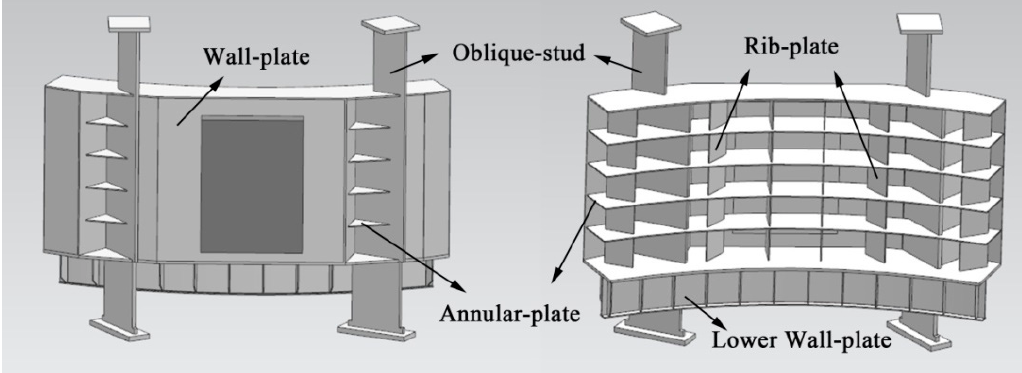
Figure 1. Structure diagram of the stator frame.